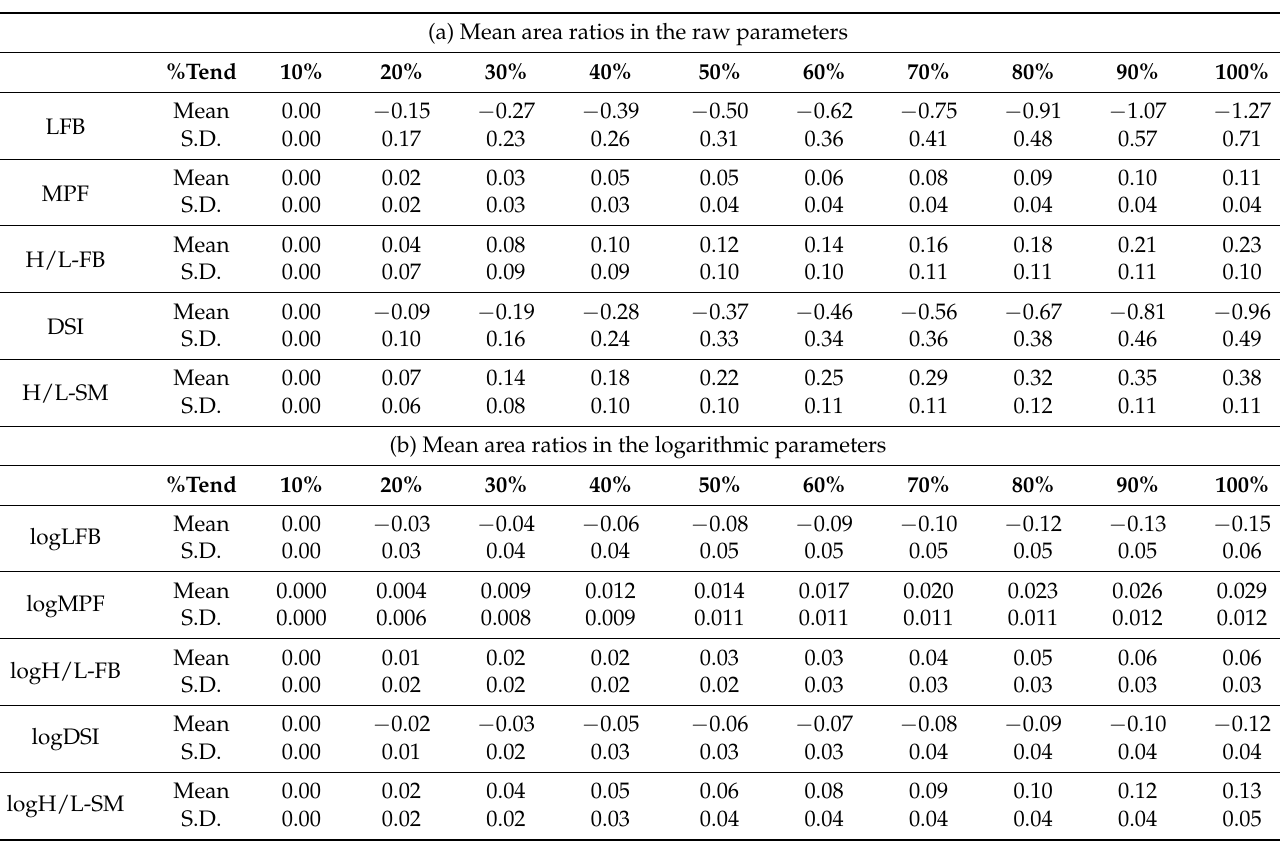
Table 3. Area ratios (mean and S.D.) in the sEMG raw parameters (a) and logarithmic ones (b) with respect to time as estimated over every 10% of T end (S.D.: standard deviation).